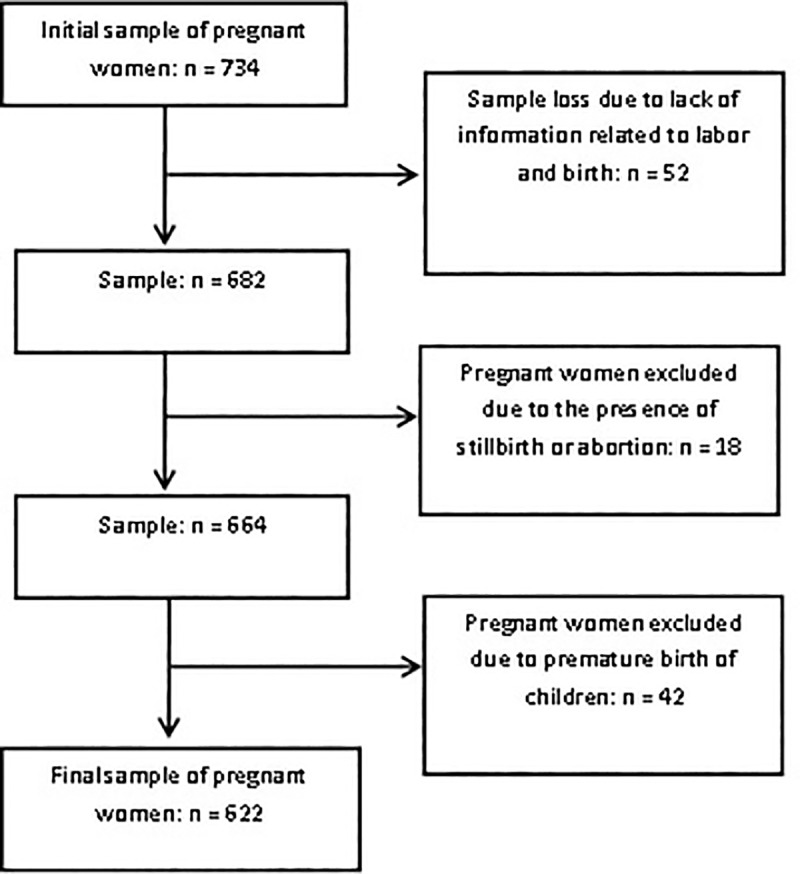
Flowchart of the sample participant selection process.